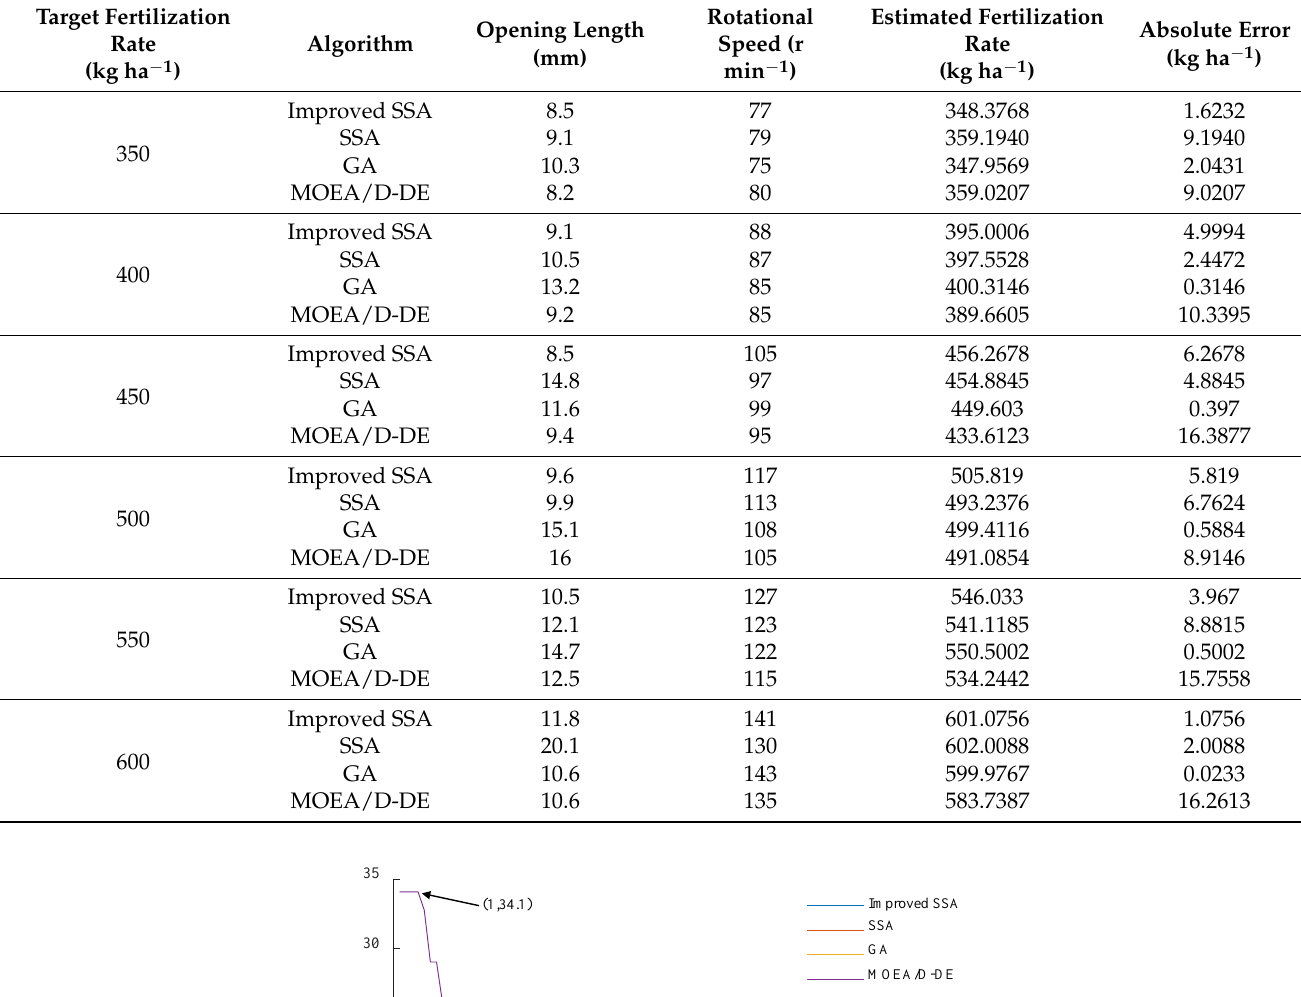
Table 8. Comparisons of four optimization algorithms for control combination.